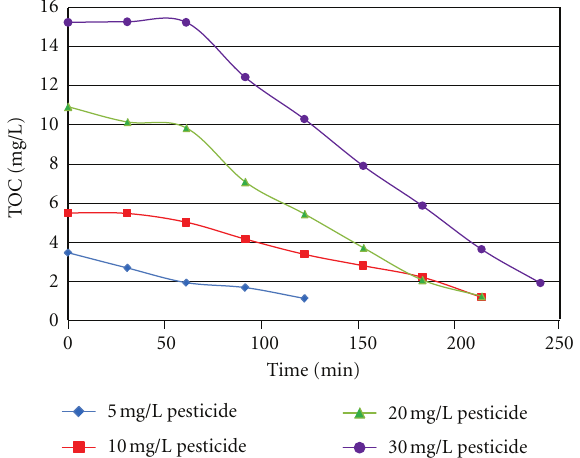
Figure 8: Heterogeneous photocatalysis of mepiquat chloride in the presence of TiO 2 P-25 and Fe +3 (initial conditions: 10ppm mepiquat chloride, 0.5g/L TiO 2 P-25, UV-A